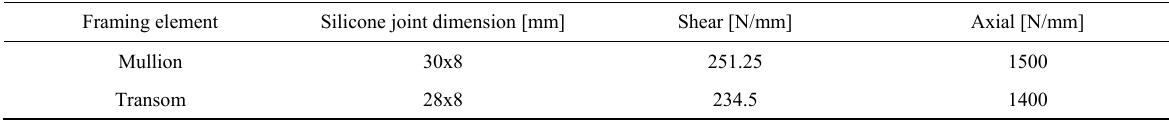
Table 1: Structural silicone spring stiffness for FEM analysis.